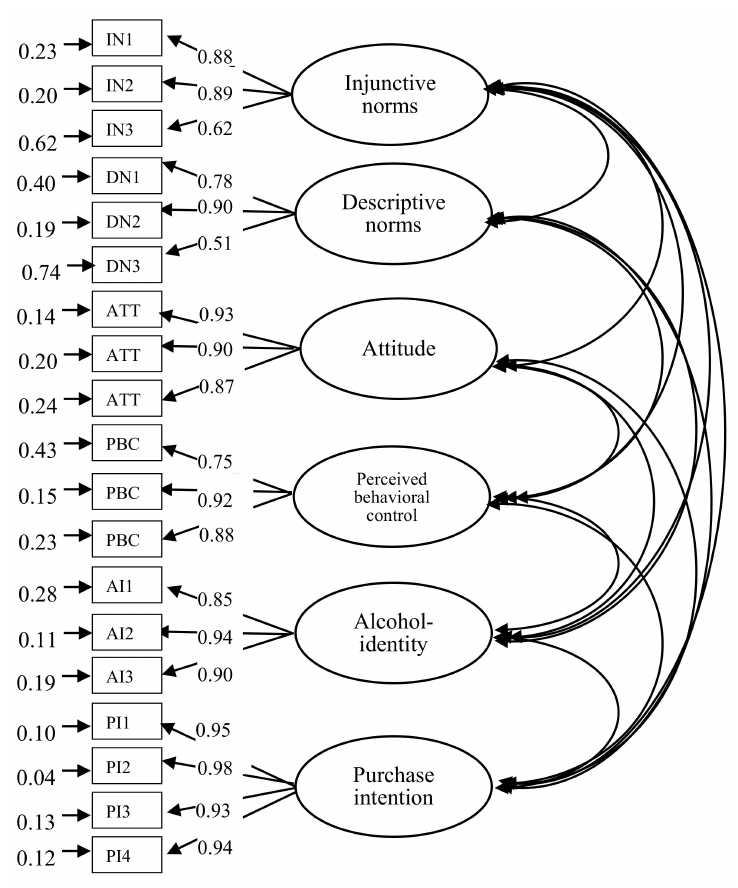
Figure 2. Confirmatory Factor Analysis (CFA)